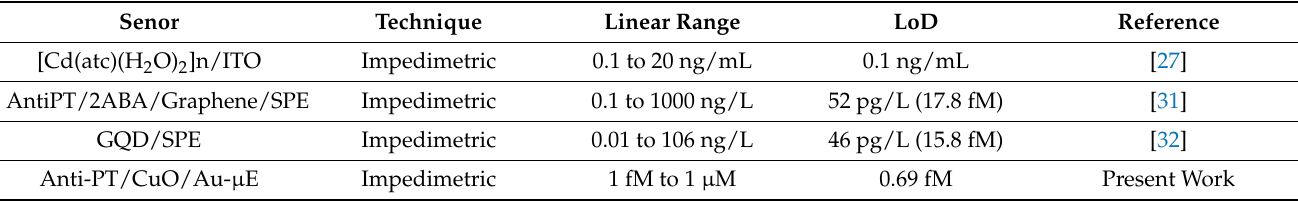
Table 1. Comparison of other sensors reported for the sensing of